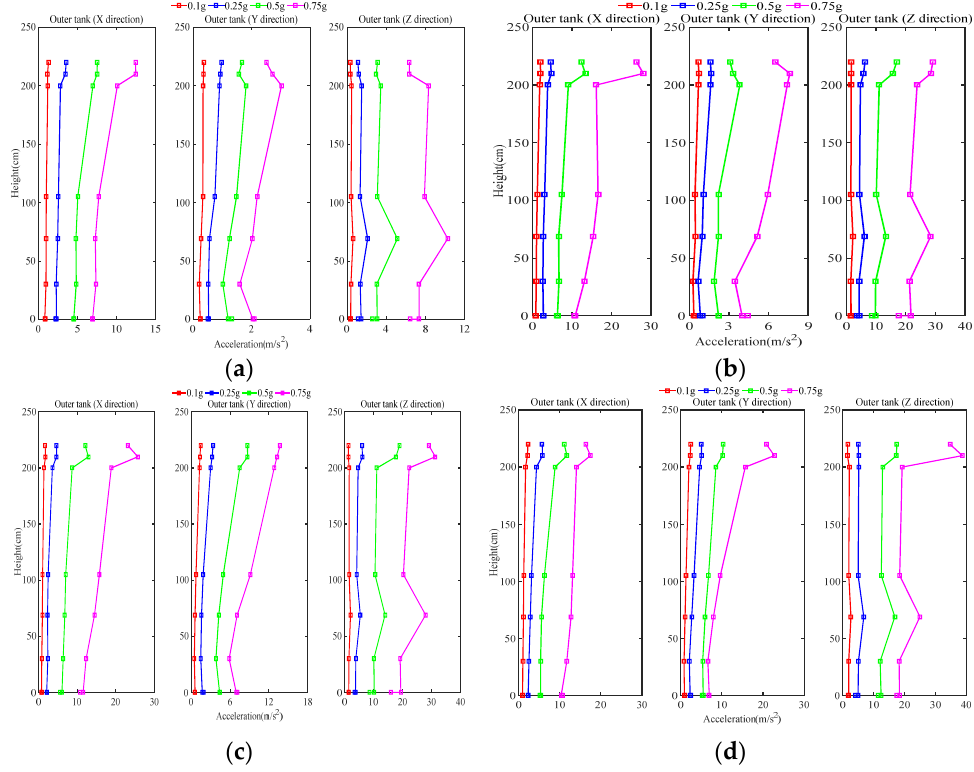
Figure 4. Variation law of acceleration response of non-isolated storage tank along height direction: ( a ) Wolong wave (X direction); ( b ) Wolong wave (XZ direction); ( c ) Wolong wave (XYZ direction); ( d ) Artificial wave (XYZ direction).